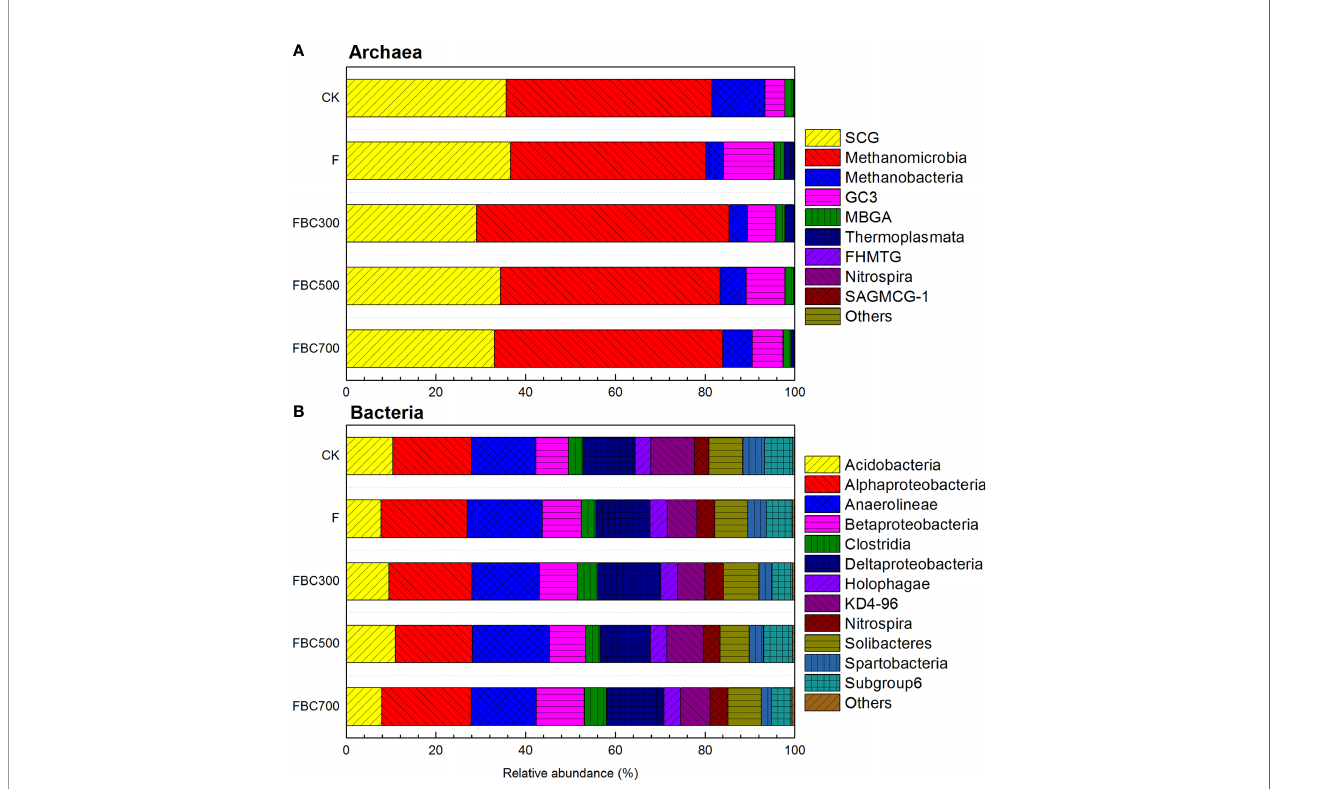
FIGURE 5 | Distributions of archaeal (A) and bacterial (B) community composition at class level in soil samples collected after 55 days column leaching of paddy topsoil (0-10cm) without fertilizer and biochar (CK), with fertilizer only (F), with fertilizer and biochar produced by wheat straw at 300°C,500°C, and 700°C (FBC300, FBC500 and FBC700). SCG represents Soil Crenarchaeotic Group; GC3 represents Group C3; MBGA represents Marine Benthic Group A; FHMTG represents FHMall terrestrial group; SAGMA-1 represents South African Gold Mine Group-1. Others of archaeal and bacterial communities include the average of low abundance but excluding the unidenti fi ed sequences.